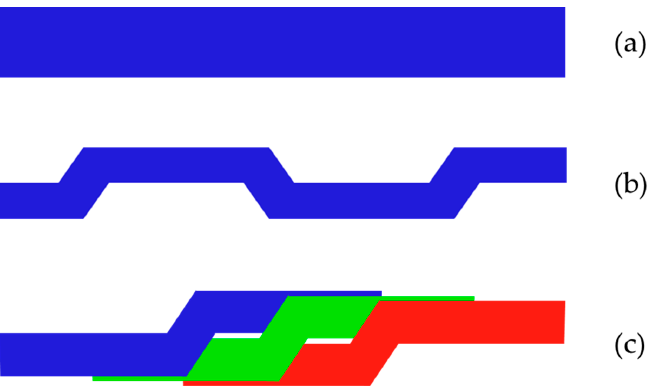
Figure 14. Schematic illustration of a full-width tape ( a ), a meandered-shape punched tape ( b ), and a Roebel cable assembly ( c ).